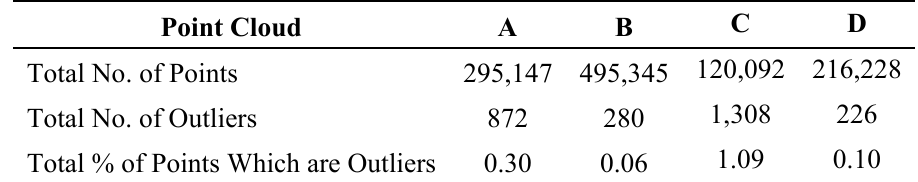
Table 1. Specifications for point clouds used in algorithm